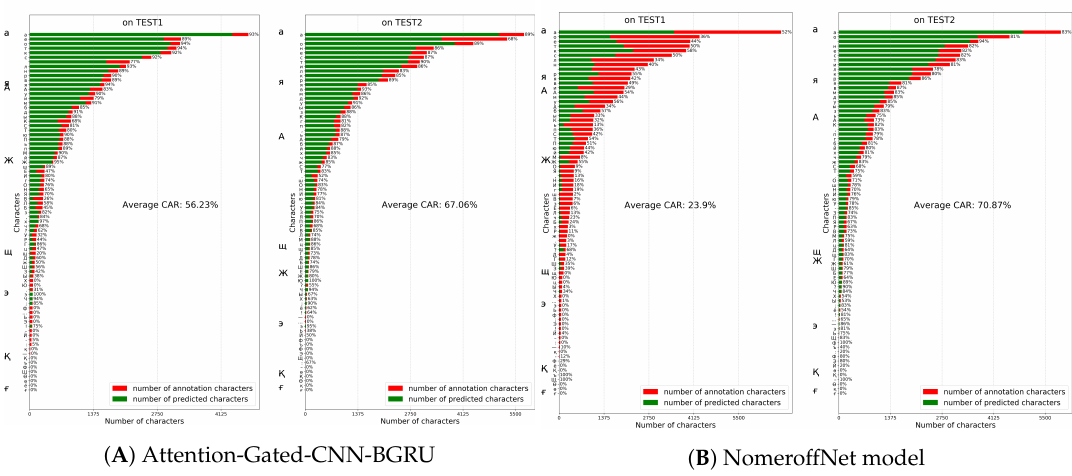
Figure 10. Attention-Gated-CNN-BGRU and NomeroffNet models performance on TEST1 and TEST2 datasets.